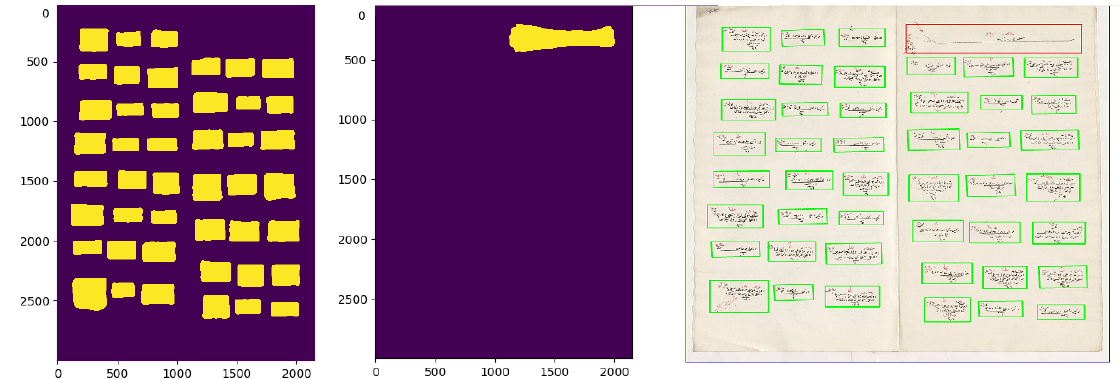
Figure 8. A sample prediction made by our system. In the left, a binarized prediction image for counting individuals, in the middle, a binarized image for counting populated place start, and in the right, the objects, enclosed with rectangular boxes. Green boxes for individual register counting and the red box for counting the populated place start object.